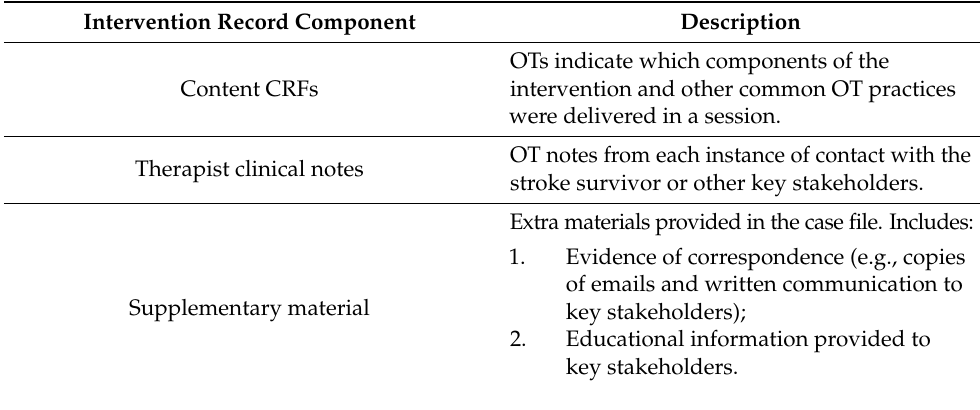
Table 1. Brief descriptions of the components of the stroke survivor intervention